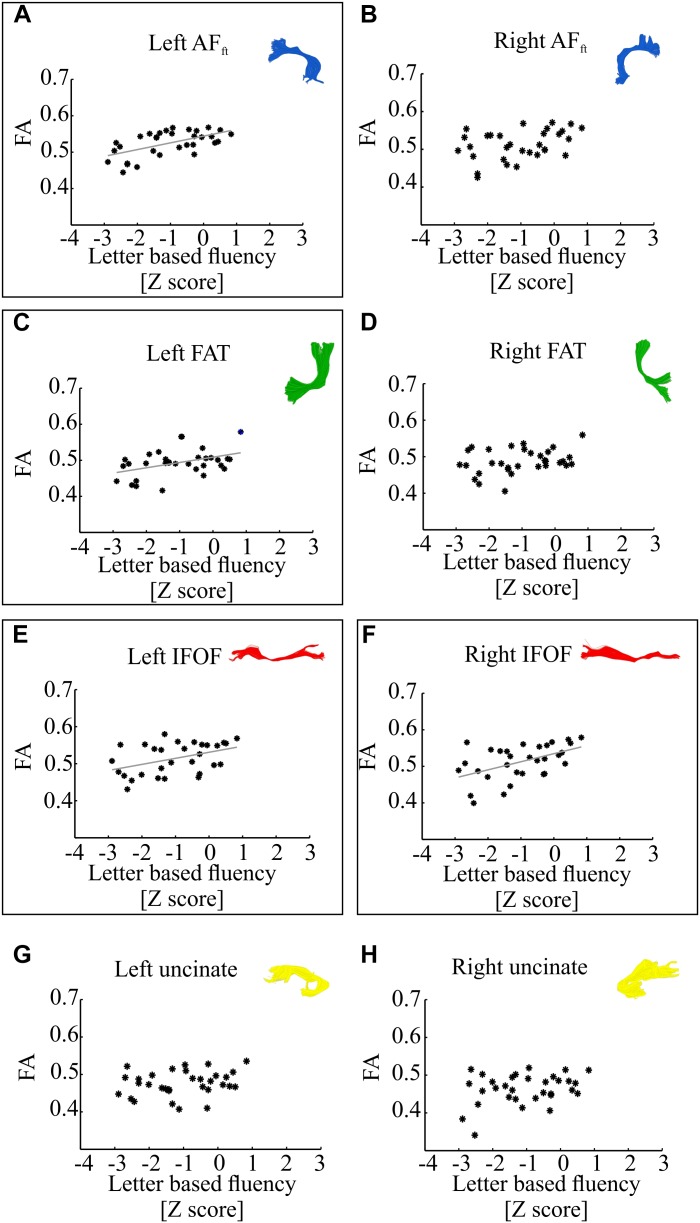
Correlations between letter-based fluency and mean tract-FA. Mean tract-FA is plotted against age-standardized letter-based fluency scores. Each dot represents an individual patient [N = 32, one additional participant was excluded from analysis due to a very high letter-based fluency score (Z = 2.97)]. Each panel plots these values for a different tract: the left and right fronto-temporal arcuate fasciculus (AFft; A,B), frontal aslant tract (FAT; C,D), inferior fronto-occipital fasciculus (IFOF; E,F), and uncinate fasciculus (G,H). Significant Pearson correlations (FDR corrected for eight comparisons, q < 0.05) are framed with a rectangle. Significant correlations were detected in the left AFft (r = 0.58, p < 0.001), left FAT (r = 0.42, p < 0.05), left and right IFOF (r = 0.42, p < 0.05; r = 0.5, p < 0.005). Gray lines represent the best linear fits for the significant associations.